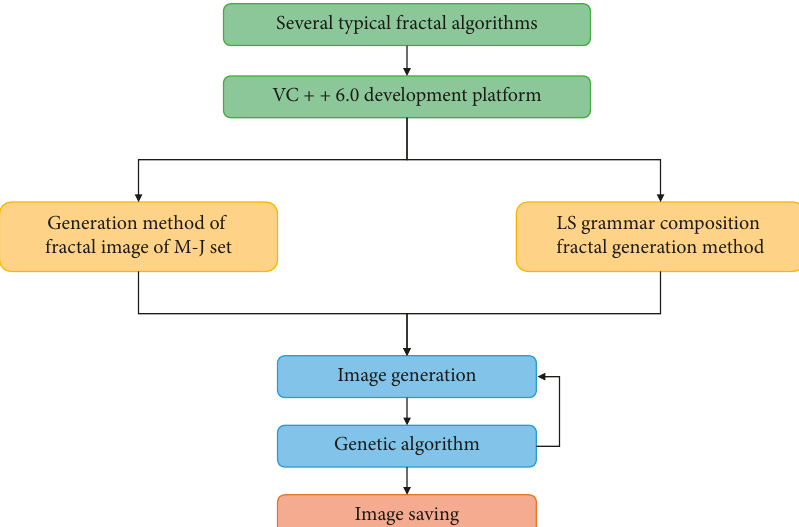
Figure 9: Programming architecture diagram.